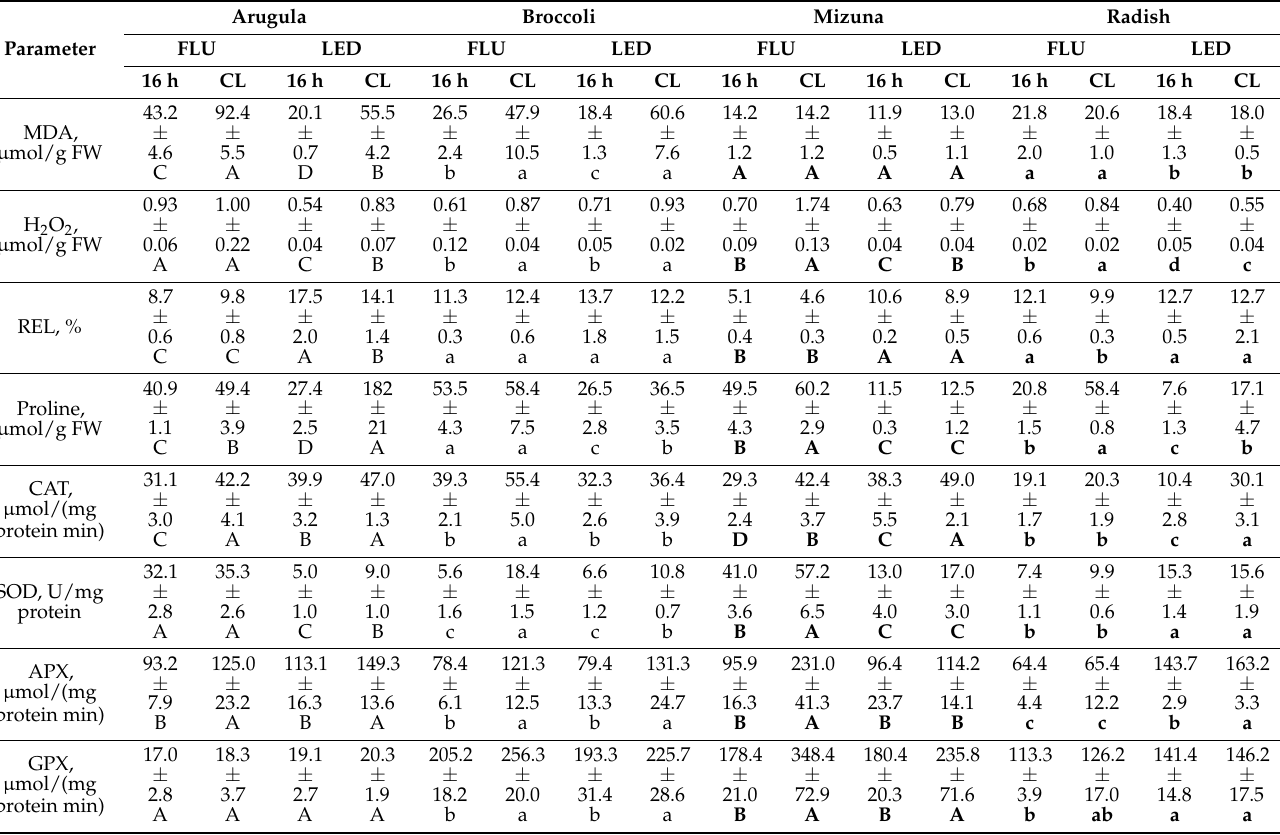
Table 3. The malondialdehyde (MDA), H 2 O 2 , proline content, relative electrolyte leakage (REL) and catalase (CAT), superoxide dismutase (SOD), ascorbate peroxidase (APX), and guaiacol peroxidase (GPX) enzyme activities of microgreens grown under 16 h photoperiod or continuous light provided by fluorescent (FLU) lamps or